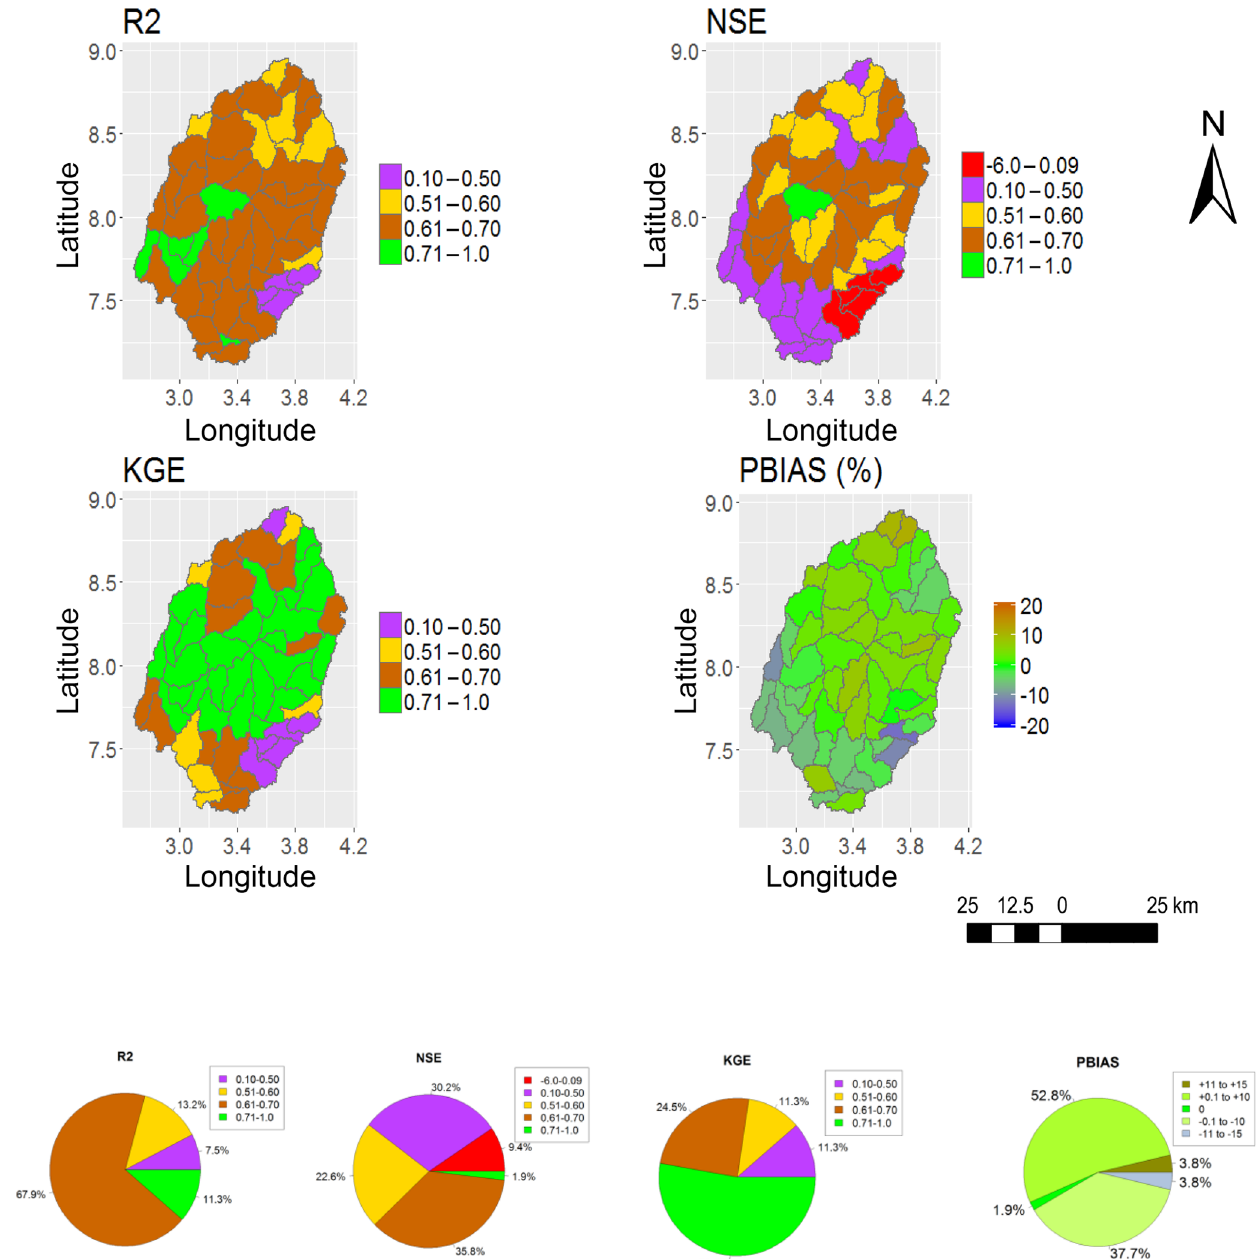
Figure 5. Performance metrics (NSE, KGE, R 2 and PBIAS) of SWAT (SWAT_HG) when validated with GLEAM_v.3.0a